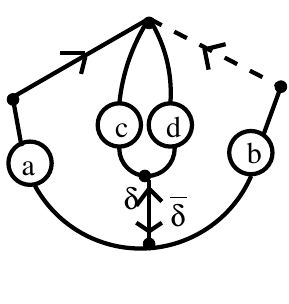
Figure 18 . P 1 ( a; b ; c; d